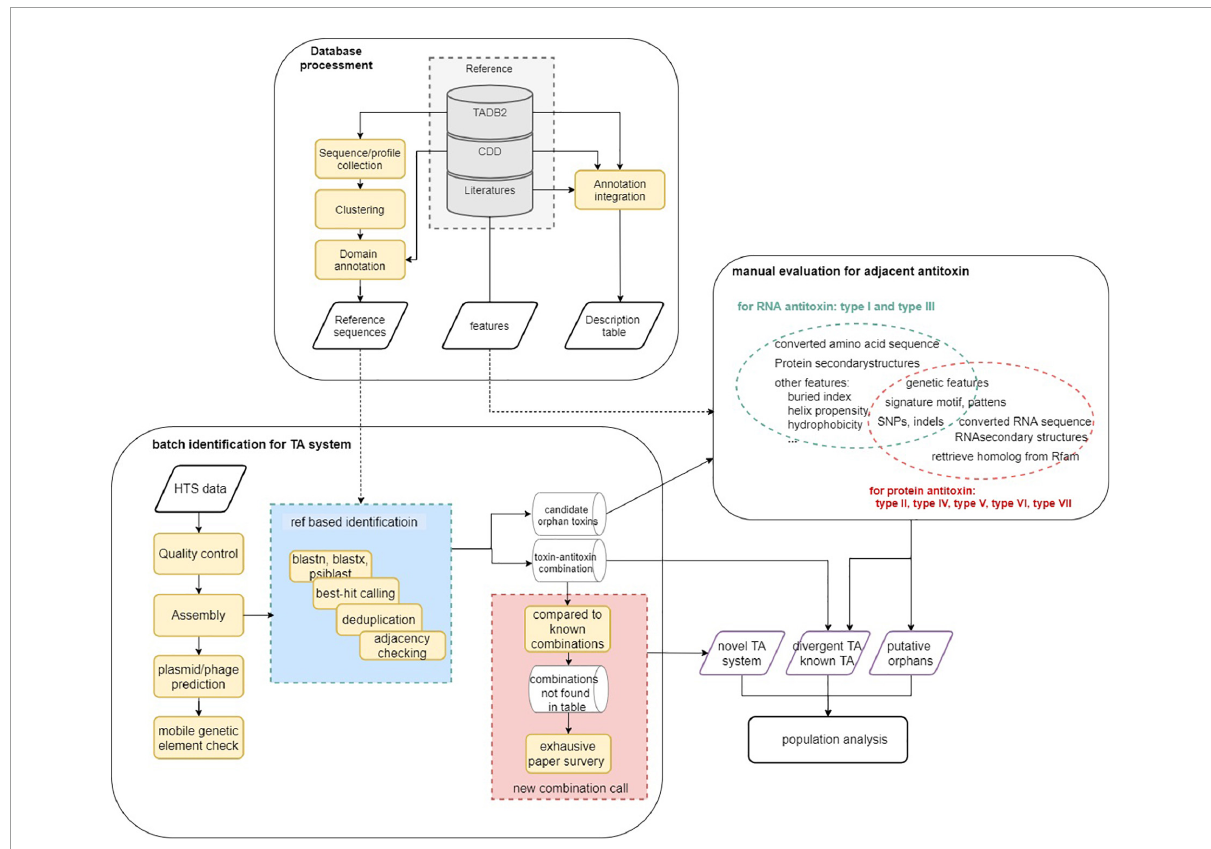
FIGURE1 Schematic overview of the analysis workflow. Step 1. Database curation and setting-up for downstream analysis. Step 2. TA identification using homology-based strategy. Step 3. Rule-based TA identification (for orphan) and functional inspection. Step 4. Update the reference data using identified TA systems and perform homologous TA module characterization in P. aeruginosa